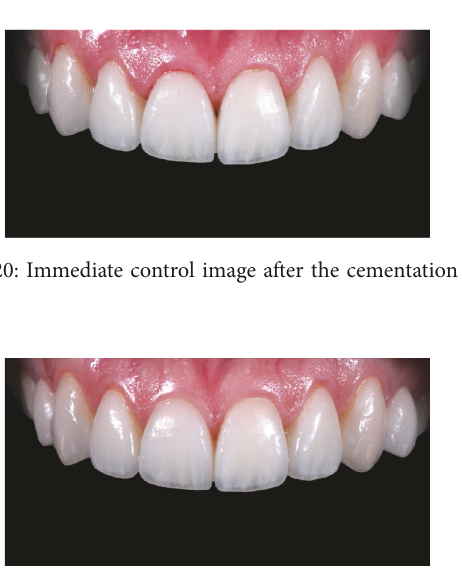
Figure 21: 11-month control imagen after treatment. Final